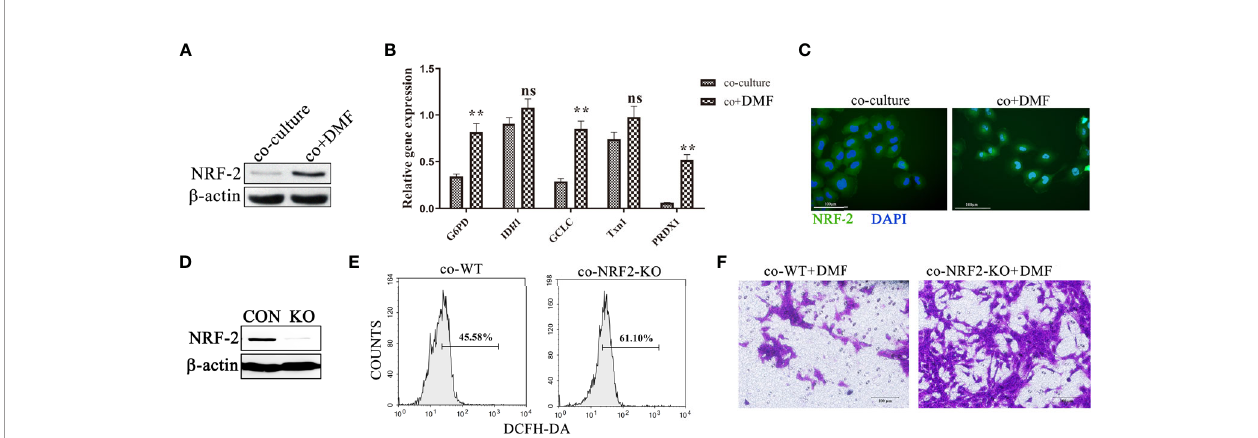
FIGURE 5 | DMF inhibits TAM pro-invasion ability via the activation of NRF2 . (A, B) In the presence or absence of DMF, RAW264.7 and 4T1 cells were co-cultured for 48 h. Western blotting was used to detect the expression of NRF2 in RAW264.7, and qPCR was used to detect the mRNA levels of G6PD, IDH1, GCLC, Txn1, and PRDX1 in RAW264.7 cells. (C) Representative fl uorescent images of NRF2 localization in RAW264.7 cells co-cultured with 4T1 cells in the presence or absence of DMF. (D) Western blot analysis of the expression of NRF-2 in RAW264.7 cells with and without NRF-2 knockout. (E) Control RAW264.7 and NRF2 knockout RAW264.7 cells were cultured with 4T1 tumor cells for 48 h. ROS production was detected by fl ow cytometry. (F) In the presence of DMF, 4T1 tumor cells were co- cultured with control RAW264.7 and NRF2 knockout RAW264.7 cells for 48 h to detect their invasion ability. Data are presented as the mean ± standard error and represent at least three independent experiments with three replicates. ns, no signi fi cance; ** P < 0.01, as determined by Student ’ s t